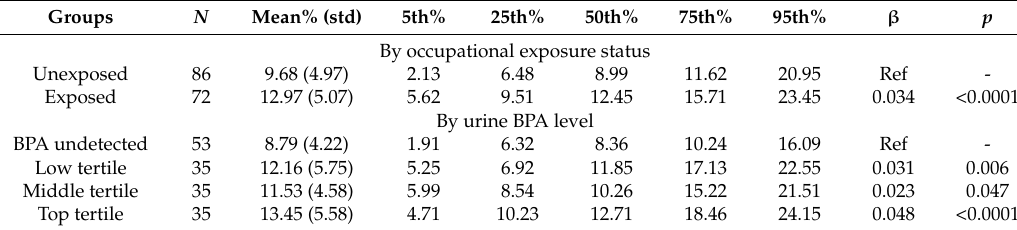
Table 3. BPA exposure and the 5hmC rate of